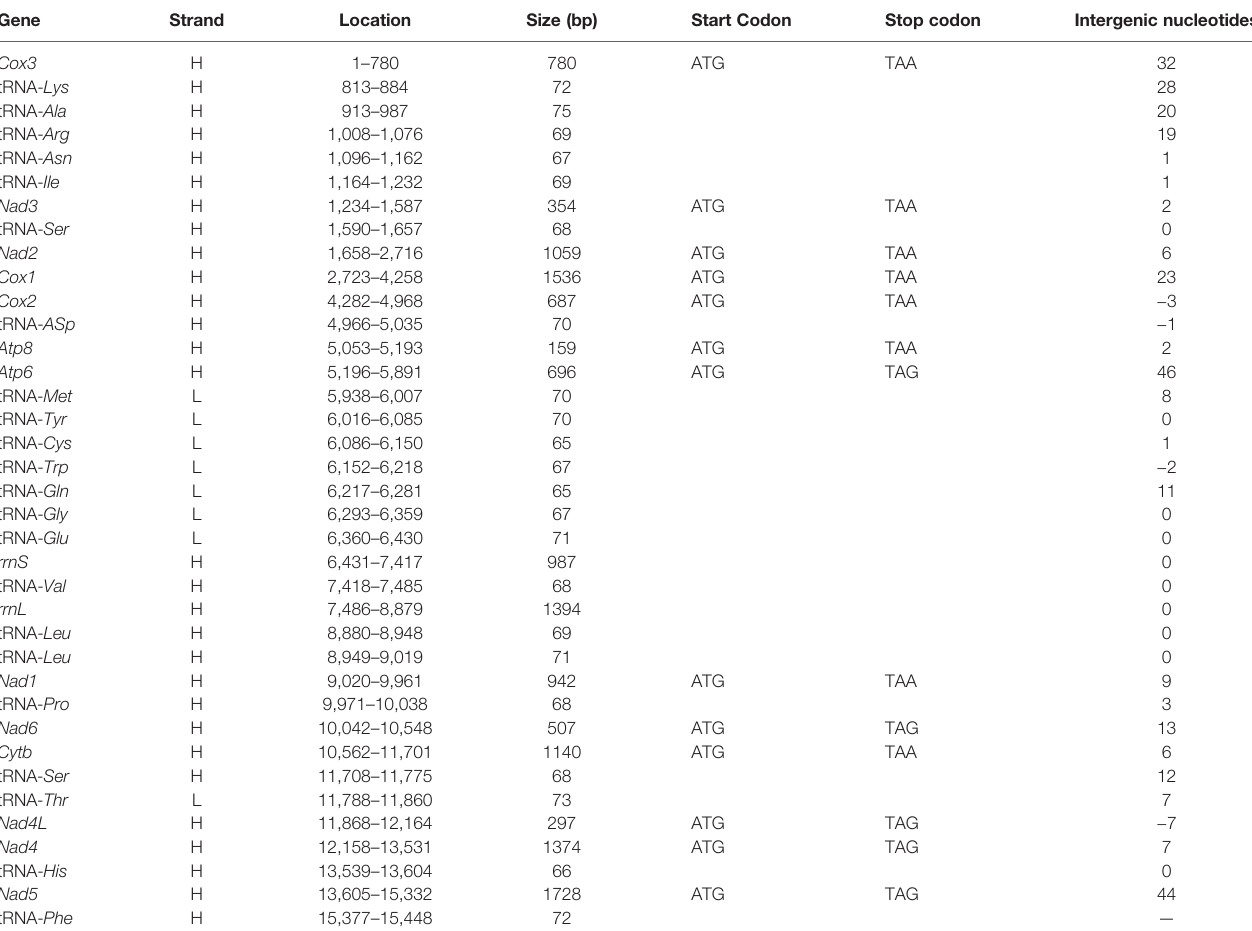
TABLE 2 | Gene annotations of the complete mt genome of Lentigo lentiginosus .